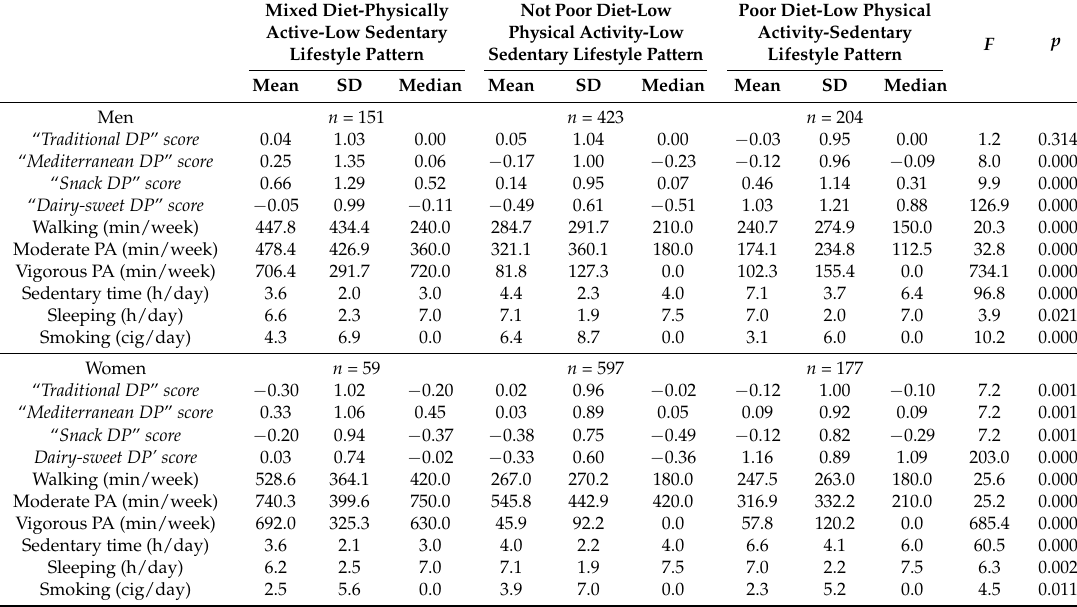
Table 2. Physical activity behaviors, sedentary, sleep time on weekdays, smoking behavior, and dietary pattern scores in the lifestyle patterns by gender